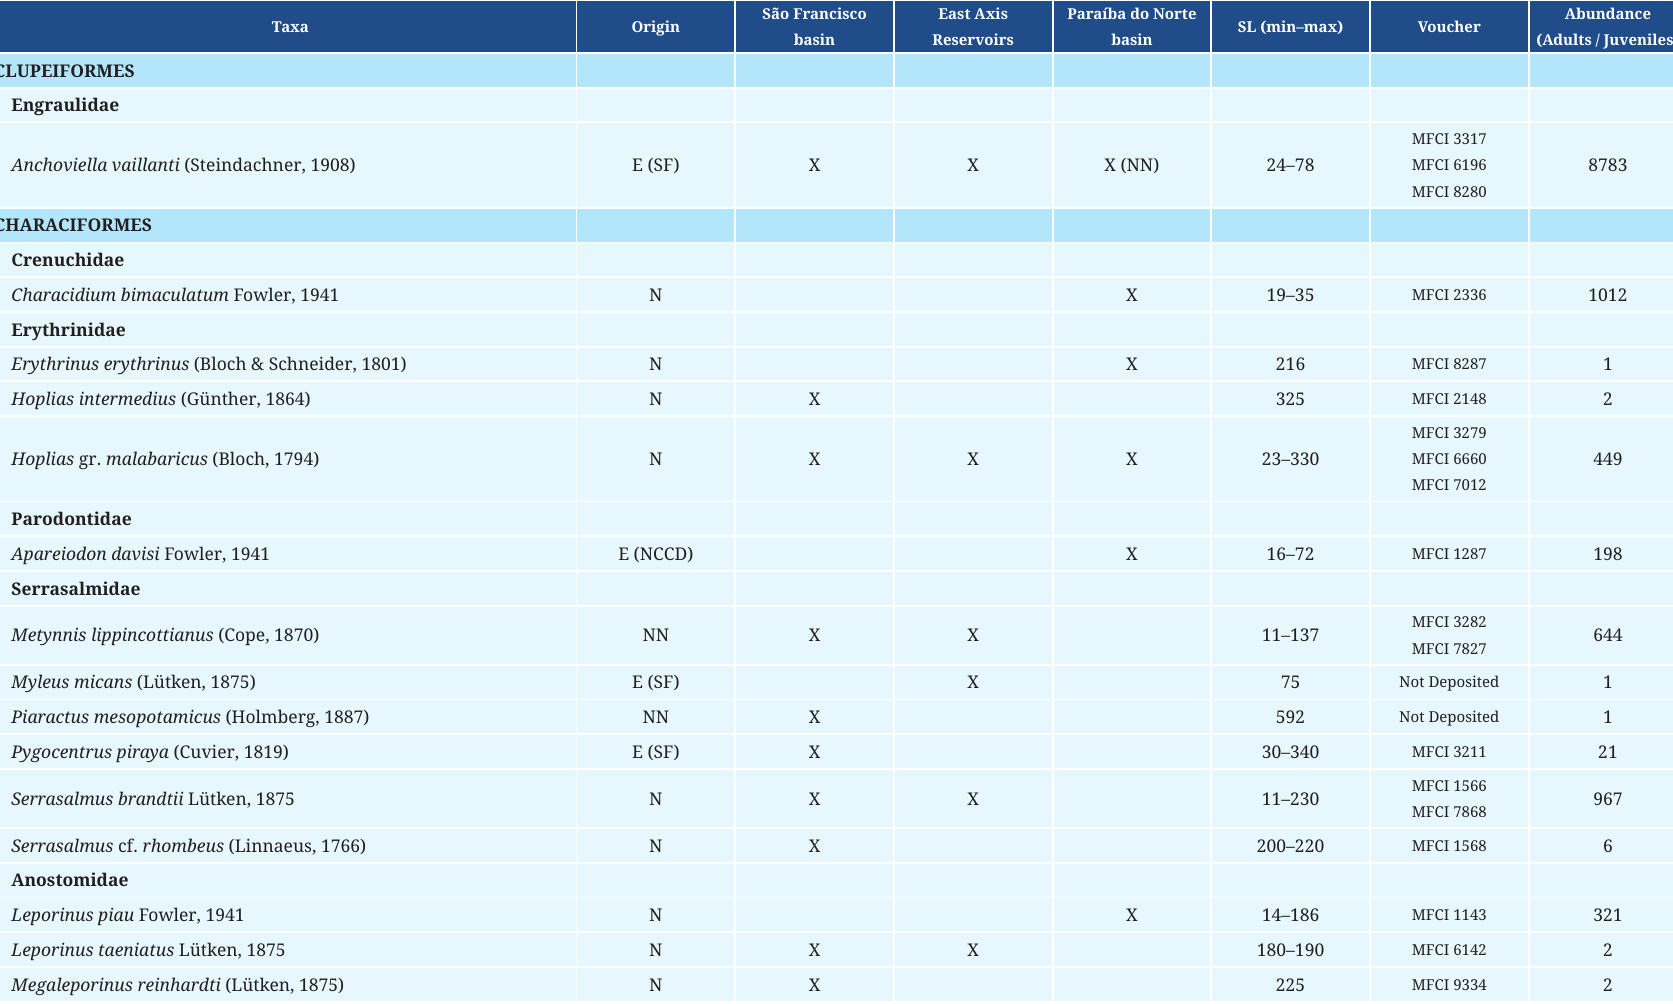
TABLE 1 | List and respective occurrences and abundances of species recorded during the SF-IWT Ichthyofauna Monitoring. The Origin column indicates native (N), endemic (E) and non-native species (NN) considering the hydrographic ecoregions of São Francisco (SF) and Northeastern Caatinga and Coastal Drainages (NCCD). SL = standard length